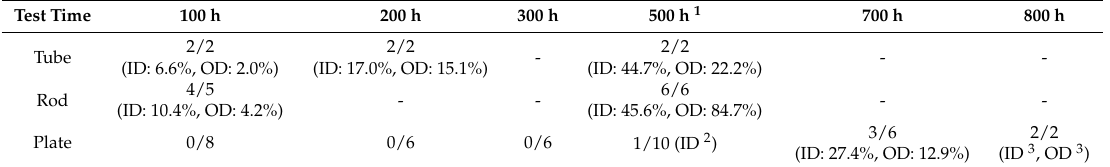
Table 4. Summary of PWSCC initiation test expressed as ‘# of specimens with crack/# of tested